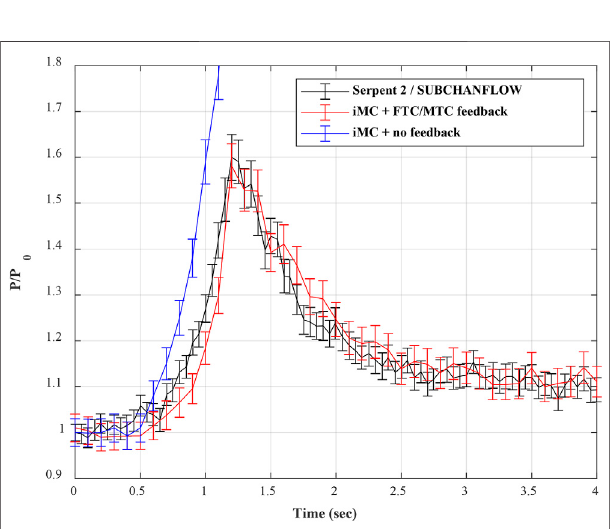
FIGURE 10 | Comparison of Serpent/SUBCHANFLOW and iMC multi- physics using TMI-1 mini-core problem.